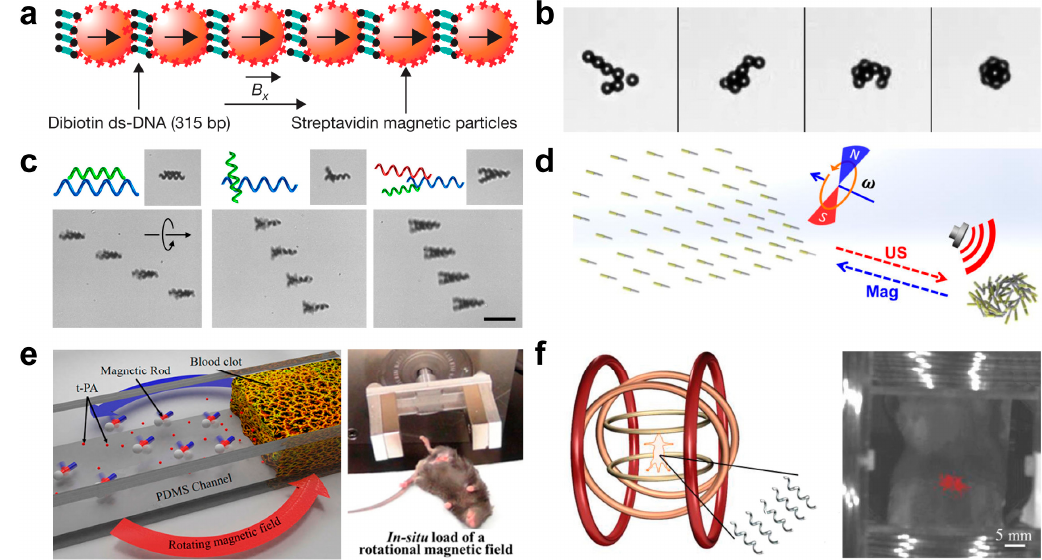
Figure 4. Magnetic field induced swarming and assembly of micro/nanoparticles. ( a ) Magnetic field B x guided the particles modified with streptavidin to interact with biotin-modified double-stranded DNA and to form filaments via the specific biotin-streptavidin interaction (reproduced from [64]). ( b ) Rotating magnetic field B x + B y for colloids assembly (reproduced from [65]). ( c ) Magnetically assisted assembly and disassembly of microhelices (reproduced from [66]). ( d ) Complex spatial-temporal collective behaviors of magneto-acoustic hybrid nanomotors (reproduced from [67]). ( e ) Rotating magnetic nanomotors enhanced the mass transport of t-PA molecules at the blood clot interface for local ischemic stroke therapy (reproduced from [68]). ( f ) Controlled swimming of a swarm of artificial bacterial flagella in the intra peritoneal cavity of a Balb-C mouse (reproduced from [69]).